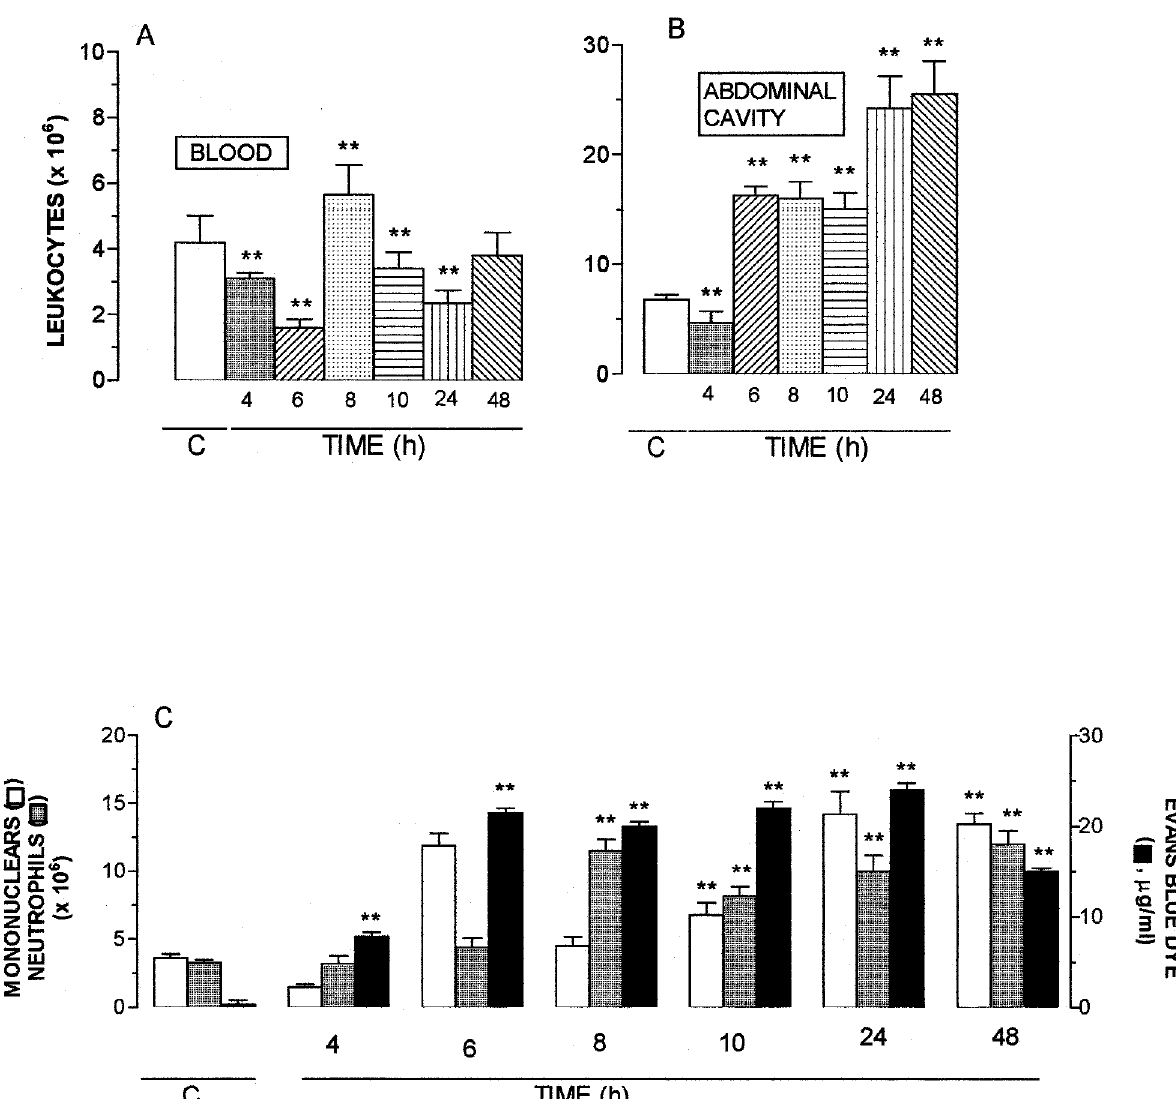
FIG. 2. Kinetics of leukocyte changes in the blood (A) and in the abdominal cavity (B) induced by polymicrobial peritonitis. Number of mononuclear, neutrophil cells and Evans blue leakage (C) in the abdominal cavity. (C) Control (sham-operated animals). Each column represents the mean of a pool of four to six animals, and the vertical bars the SEM. ** p <